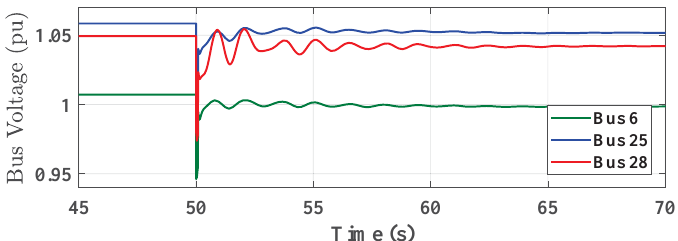
Figure 8. Bus 6, 25, and 28 voltage magnitude responses to generator 5 trip at t = 50 s for the PE-based power system case study (case study 2).